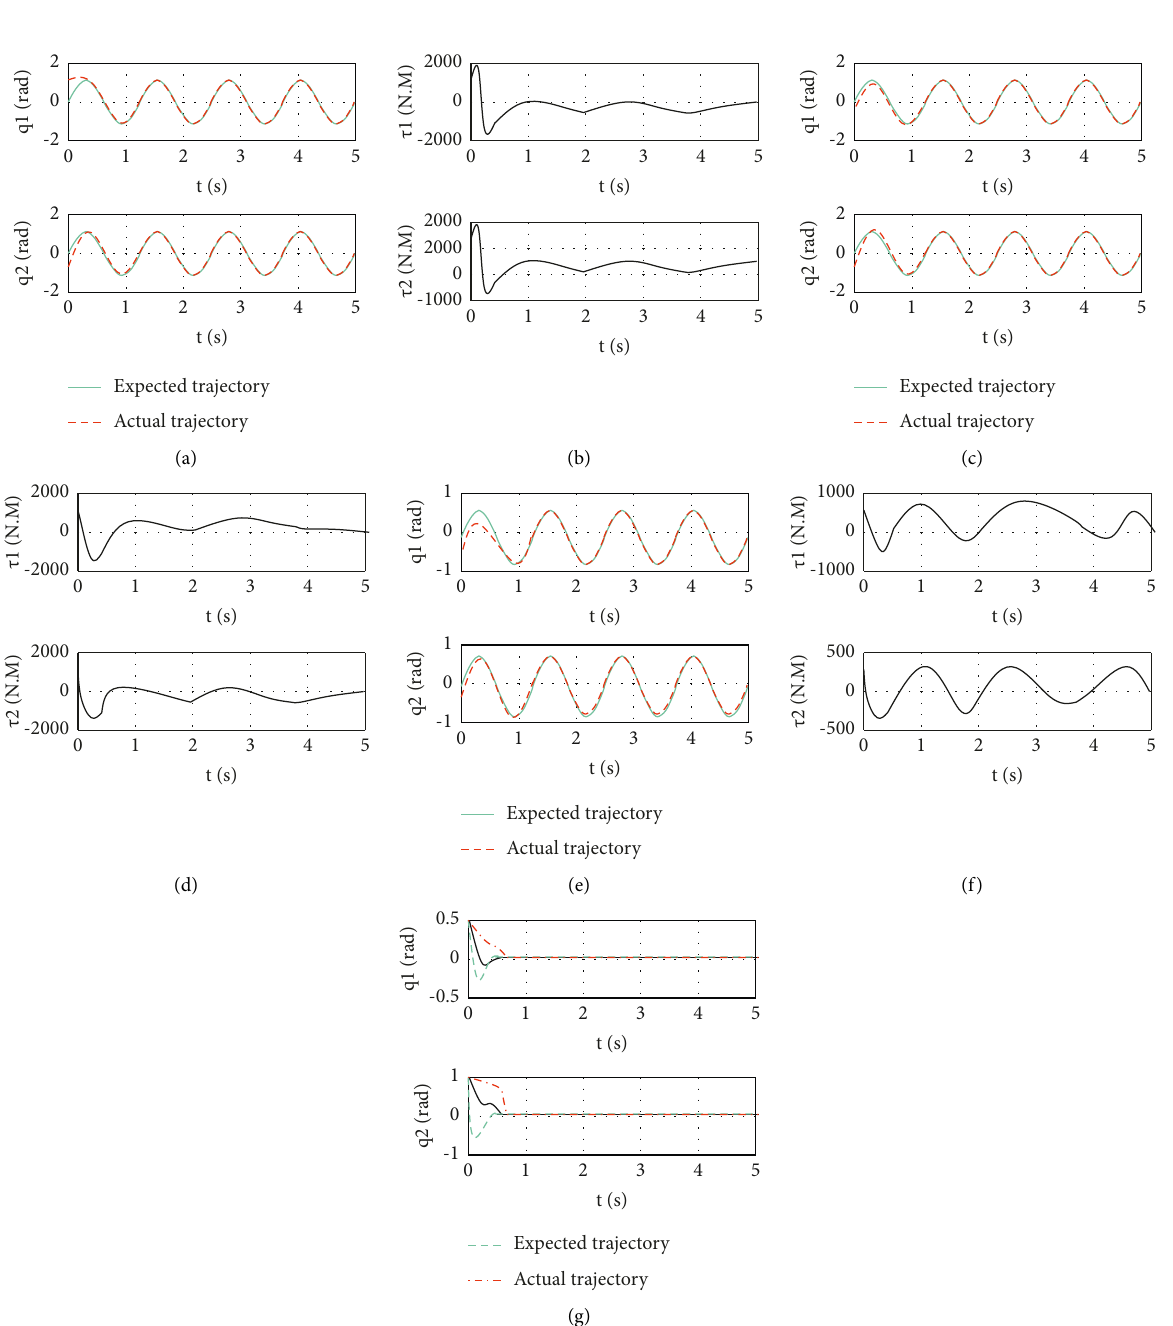
Figure 2: Simulation diagram of the desired trajectory. (a)Position trajectory curve of strategy 1. (b)Control input curve of strategy 1. (c) Position trajectory curve of strategy 2. (d)Control input curve of strategy 2. (e)Position trajectory curve of strategy 3. (f)Control input curve of strategy 3. (g)Comparison of position tracking error curves of the three control